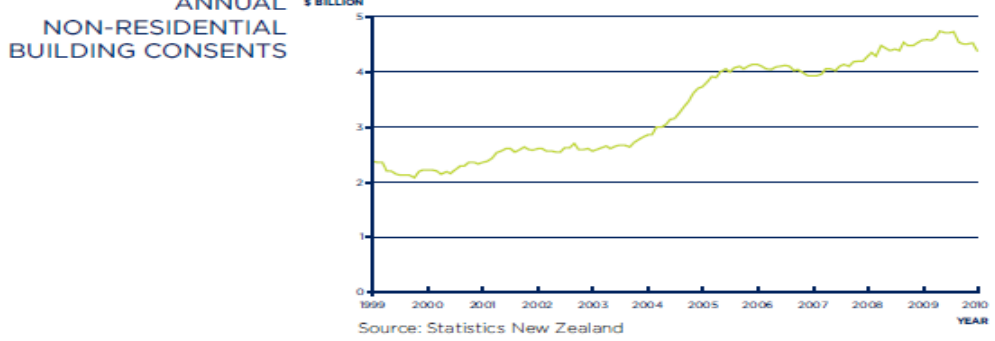
Figure14 Annual Non-Residential Building Consents